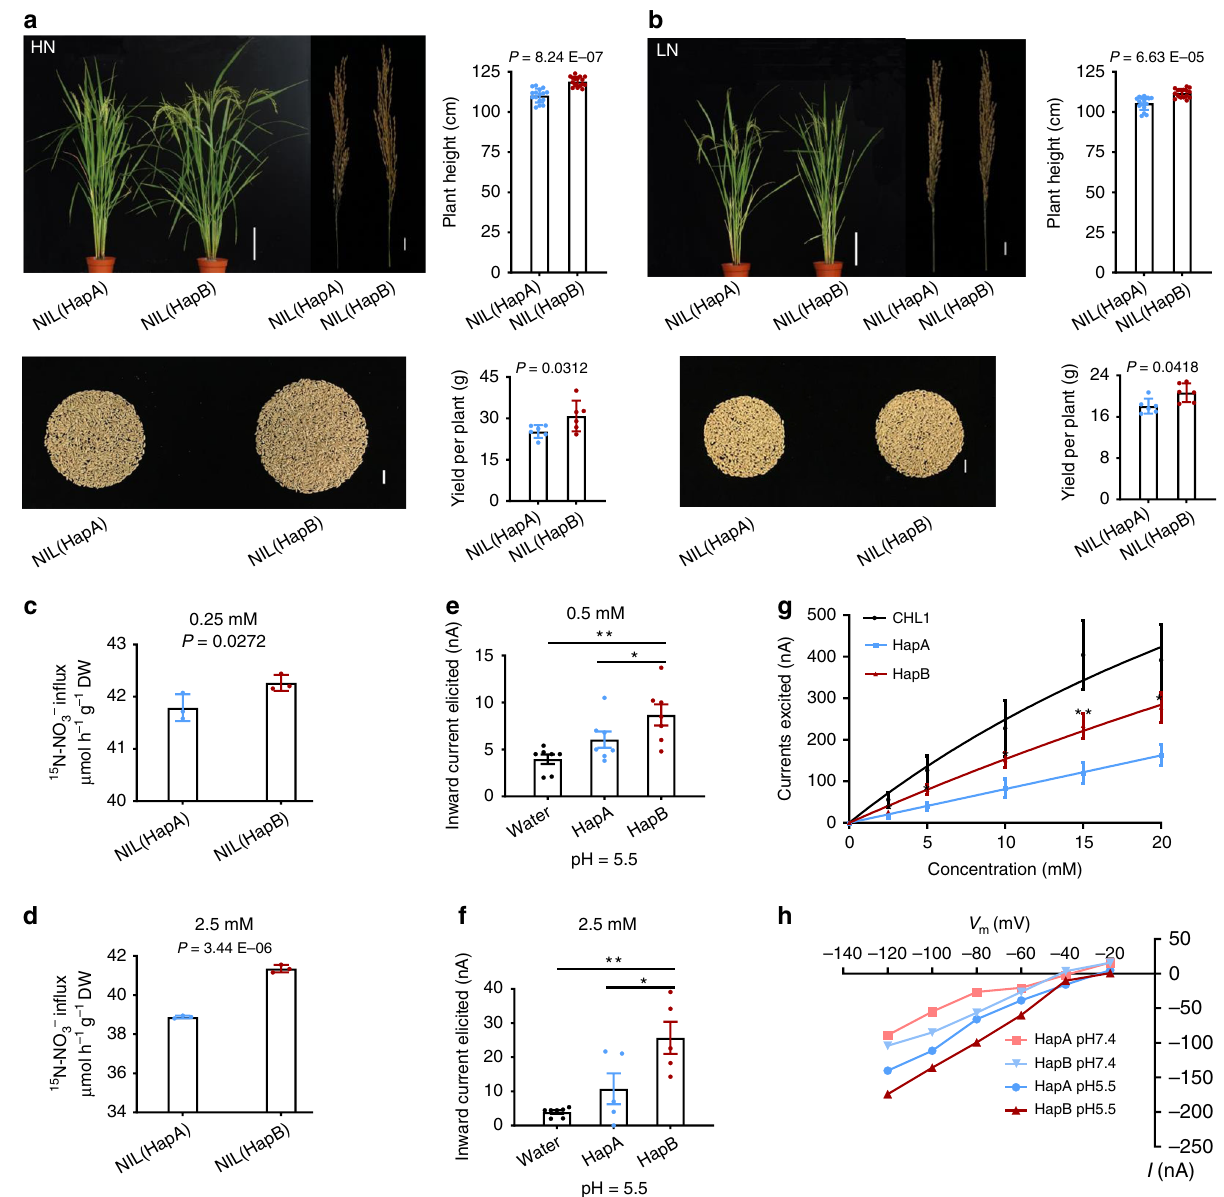
Fig. 2 Functional analysis of OsNPF6.1. a , b Comparison of the plant heights and yields per plant of NIL (HapA) and NIL (HapB), under HN ( a ) and LN ( b ) conditions, bar = 20 cm (the plants), 2 cm (the panicles and the seeds), n = 16, 6. c , d Nitrate in fl ux rates in the roots. The root nitrate in fl ux was measured in 0.25 mM ( c ) or 2.5 mM ( d ) 15 NO 3 − , n = 3. Data are presented as means± SD. P values were calculated with Student ’ s t test. e , f Averages of the currents elicited under 0.5 mM ( e ) and 2.5 mM NO 3 − ( f ) in oocytes injected with complementary RNAs of the coding regions of two haplotypes ( OsNPF6.1 HapA and OsNPF6.1 HapB ) of OsNPF6.1 or water control. The oocytes were voltage-clamped at − 60 mV, and the inward currents elicited with 0.5 mM or 2.5 mM NO 3 − at pH 5.5. Bars represent mean ± SEM, n = 7 ( e ), n = 7, 5, 5 ( f ). One-way analysis of variance (ANOVA) followed by Tukey ’ s multiple comparison test was used to analyze statistical signi fi cance (* P < 0.05 and ** P < 0.01). g Concentration dependence of nitrate-elicited currents in a single injected oocyte. The oocyte was voltage-clamped at − 60 mV, and the currents elicited by different concentrations of nitrate (0 – 20 mM) at pH 5.5, AtCHL1 as a positive control. Each bar represents the mean ± SEM, n = 4, 10, 10 (* P < 0.05 and ** P < 0.01, Welch ’ s t test). h Current-to-voltage relationship for OsNPF6.1 HapA and OsNPF6.1 HapB . The curves presented were recorded from a single OsNPF6.1 HapA (blue) and OsNPF6.1 HapB (red)-injected oocyte treated with 10 mM nitrate at pH 5.5, and OsNPF6.1 HapA (light red) and OsNPF6.1 HapB (light blue) all at 10 mM and pH 7.4. The data in ( e – h ) obtained from independent oocytes from the same frog, and similar results were obtained from three different frogs. Source data are provided as a Source Data fi LN conditions with correlation coef fi cients of 0.61 and 0.81 (Fig. 2h). These results collectively reveal that OsNPF6.1 HapB is respectively (Supplementary Fig. 10a). Overexpression of the elite haplotype that enhances NUE by increasing N uptake. OsNPF6.1 HapA in Nip promoted EPN and YPP in HN and LN fi elds as compared to wild-type Nip (Supplementary Fig. 10b – d). These results collectively suggested that HapB was a superior Transcriptional regulation of OsNPF6.1 is critical for NUE . haplotype for NUE. As OsNPF6.1 HapB was superior to Expression of OsNPF6.1 corresponds with EPN under HN and